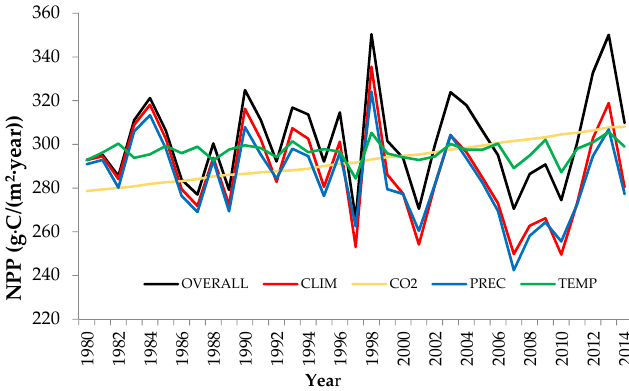
Figure 4. Dynamics of annual NPP under different scenarios (Table 3). Table 3. Experiment/scenario design.